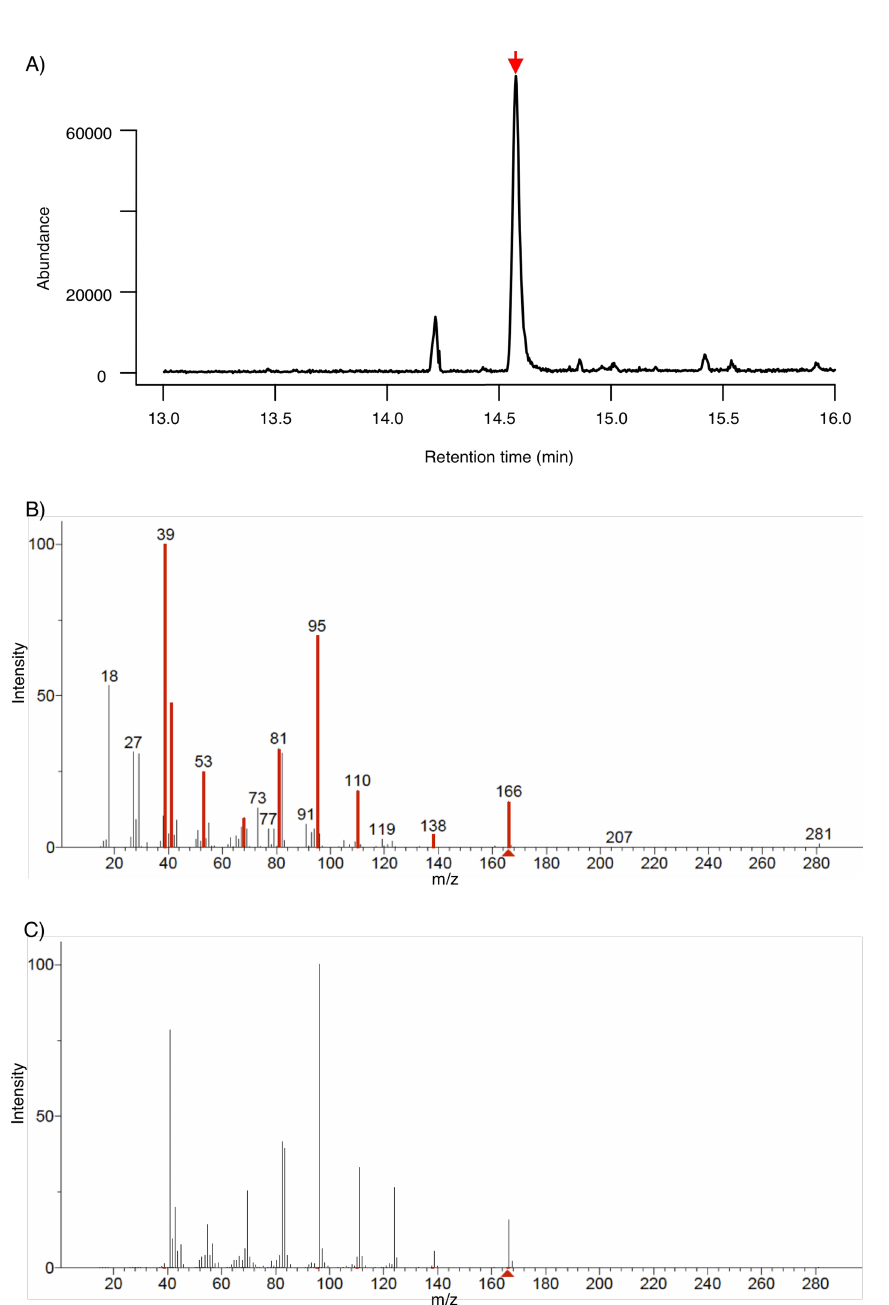
Figure 3. Identification of 6-pentyl- α -pyrone (6-PP) using gas chromatography coupled with mass spectrometry (GC-MS). ( A ) Chromatogram based on Total ion current (TIC), 6-PP was detected at minute 14.6. ( B ) Experimental GC-MS spectrum at 14.6 min. Fragments that match the 6-PP standard fragmentation pattern are highlighted in red. ( C ) NIST database hit of